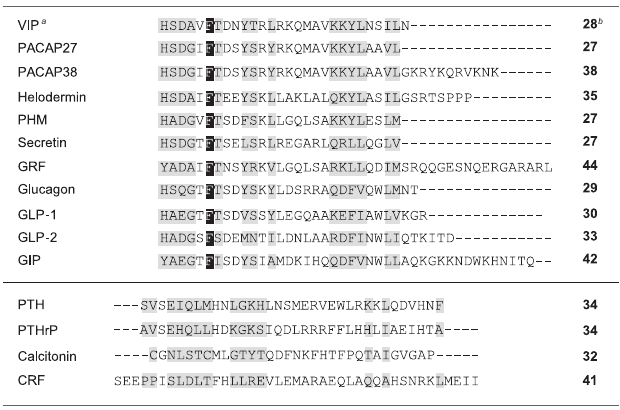
a Black boxes represent sequence identity and light gray boxes represent sequence homology. b Numbers indicate the length of the